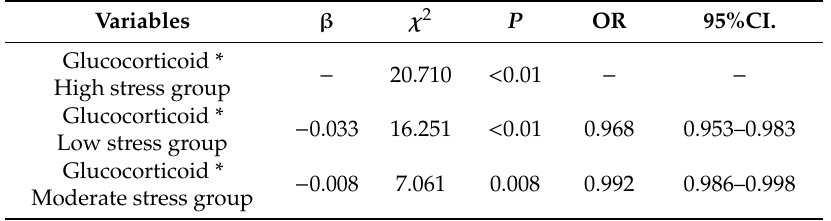
Table 7. Interaction between occupational stress, glucocorticoid levels, and sleep disorders. Variables β χ 2 P OR